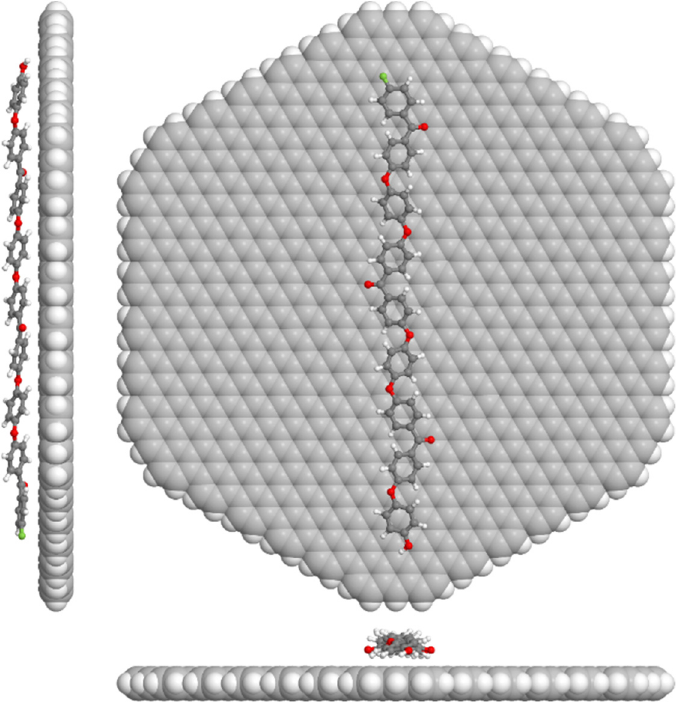
Figure 2. Computer model of PEEK adsorbed on a C 834 H 78 graphene flake.